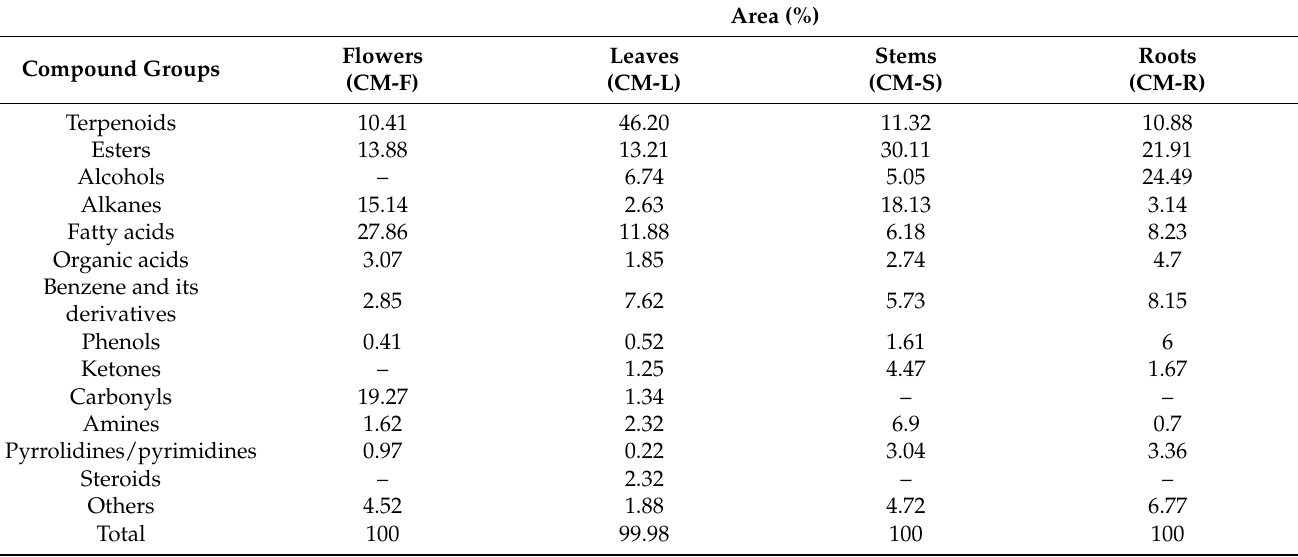
Table 2. Biomolecule groups of Cladanthus mixtus extracts obtained by